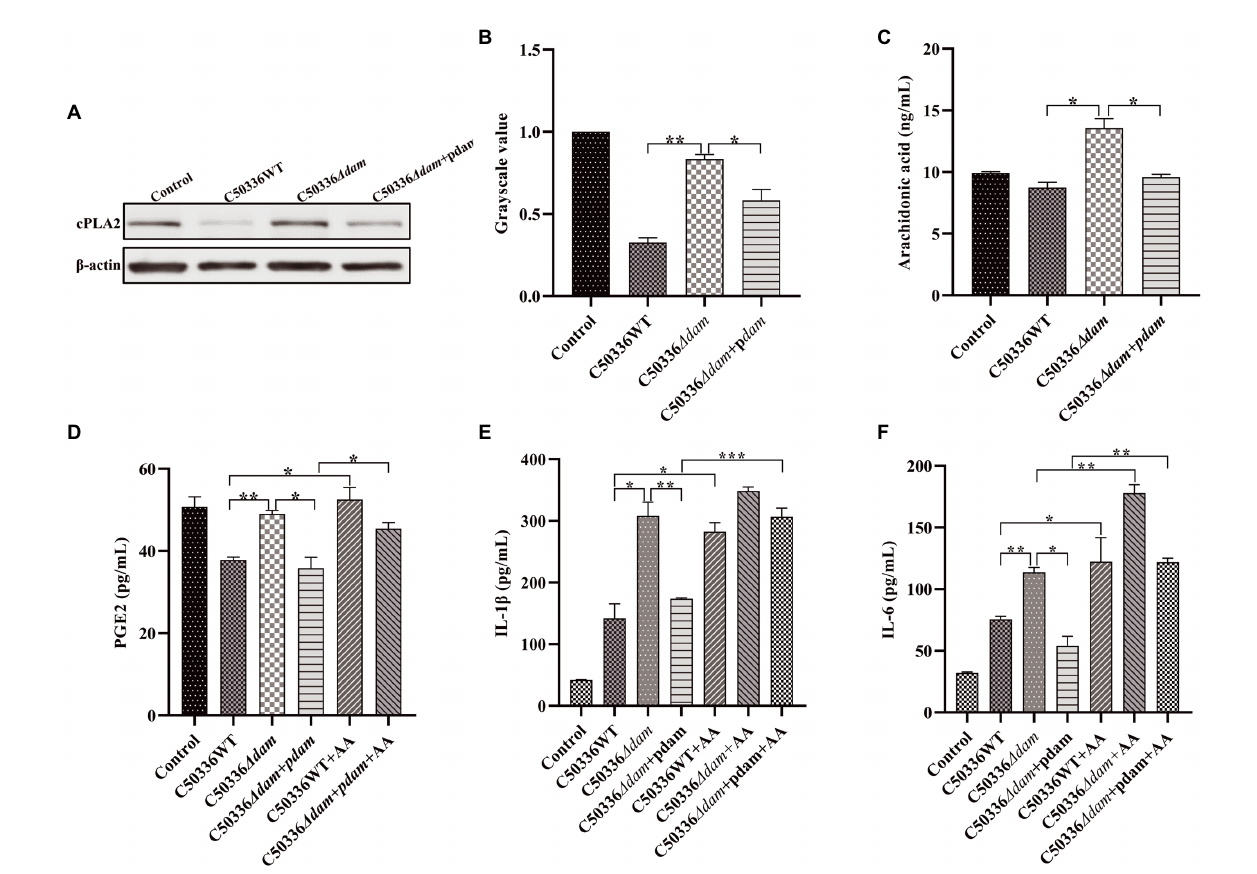
FIGURE 7 The dam gene inhibits the secretion of PGE2, IL-1 β , and IL-6 by inhibiting the production of AA. (A) The expression of cPLA2 analyzed by immunoblotting. β -actin was blotted as a loading control. (B) The gray value analysis of cPLA2 immunoblotting. (C) C50336 WT, C50336 Δ dam and C50336 Δ dam + pdam treated with J774A.1, intracellular AA concentration via ELISA. (D) PGE2 concentration via ELISA in cell culture supernatant after addition of exogenous AA (250 ng/ml). (E) IL-1 β concentration via ELISA in cell culture supernatant after addition of exogenous AA (250 ng/ml). (F) IL-6 concentration via ELISA in cell culture supernatant after addition of exogenous AA (250 ng/ml). *** p < 0.001, ** p < 0.01, * p < 0.05 for one-way ANOVA followed by Bonferroni’s